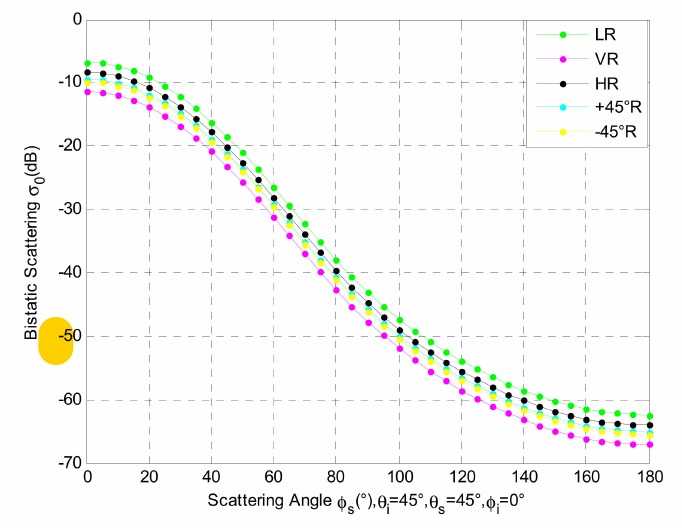
Figure 4. Bi-static scattering of various polarizations versus scattering azimuth